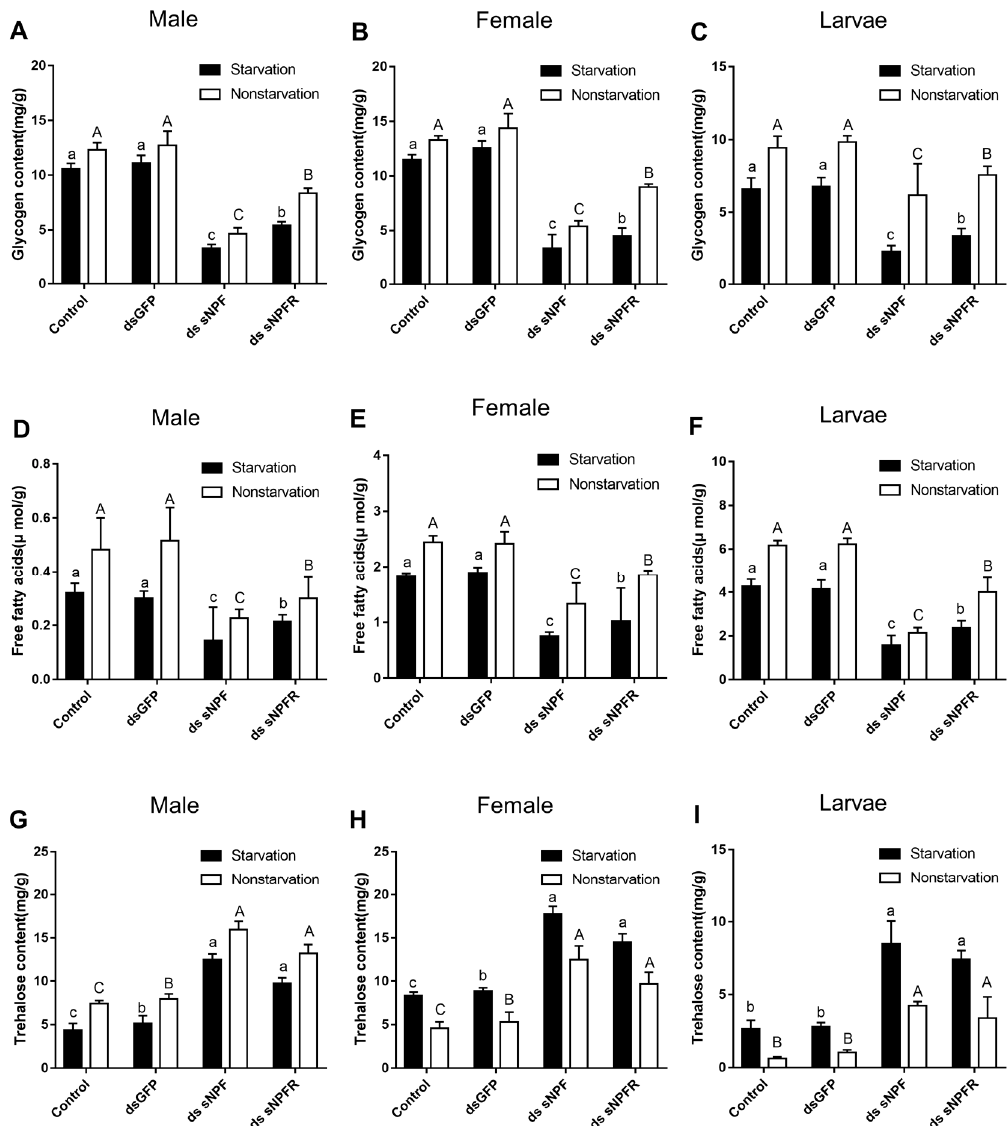
Figure 9. Effect of ds sNPF and ds sNPFR on energy metabolism. Samples were collected and assayed at 72 h after injection. Whole-body homogenates were used to measure glycogen of male ( A ), female ( B ), and larvae ( C ); free fatty acids of male ( D ), female ( E ), and larvae ( F ); and trehalose contents of male ( G ), female ( H ), and larvae ( I ) in the state of starvation and non-starvation. Different letters indicate significant differences at the 0.05 level. Tukey tests: uppercase for non-starvation, lowercase for starvation. All values are mean ± SE, n = 3.